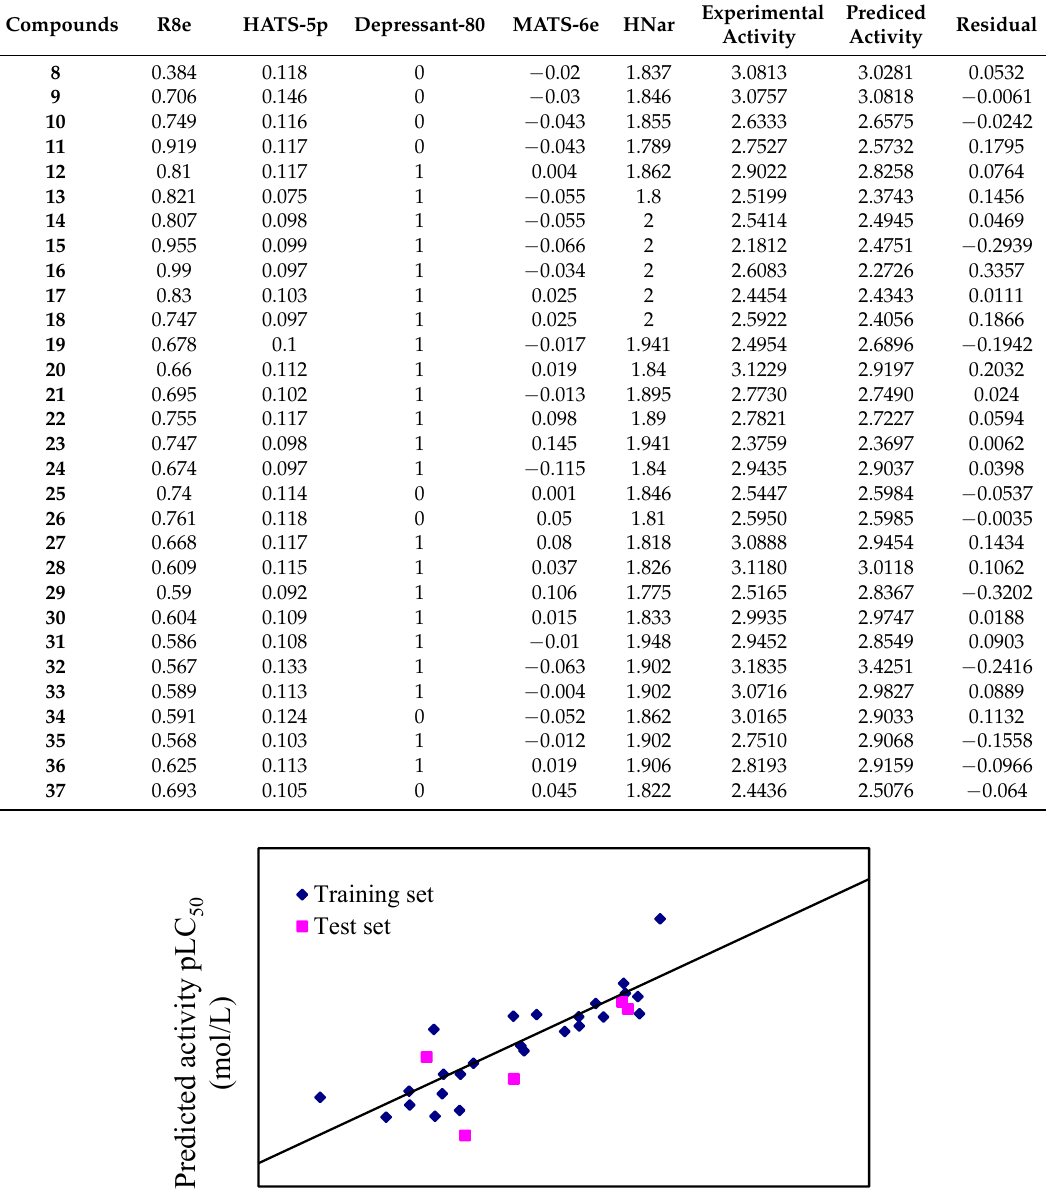
Table 5. Values of significant molecular descriptors, experimental and predicted acaricidal activities (pLC 50 , mol/L) from 2D-QSAR of the compounds 8 – 37 .